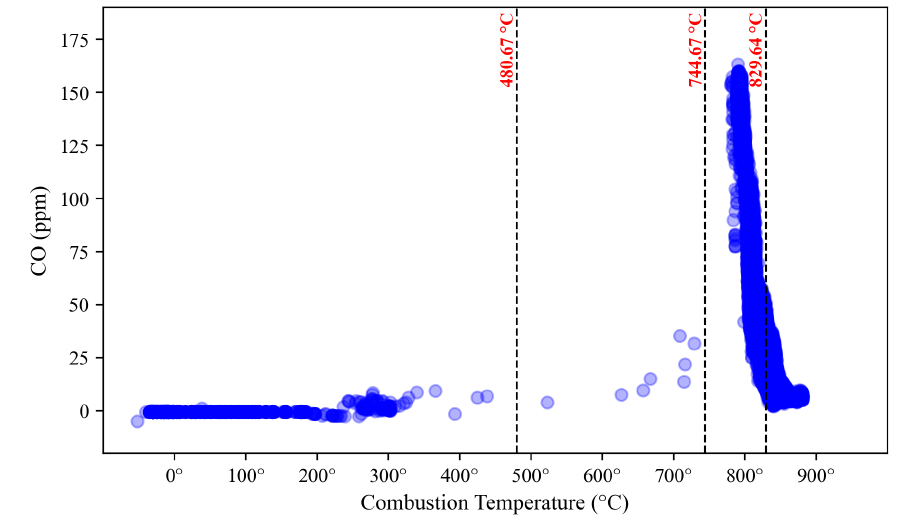
Figure 18. DLE gas turbine’s operating region based on NO x emission clustering.